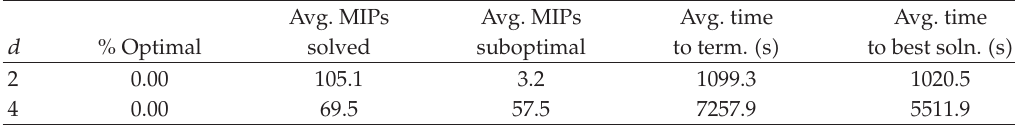
Table 8: Computational performance of L 1 OR implementation for bootstrap simulations. Avg.